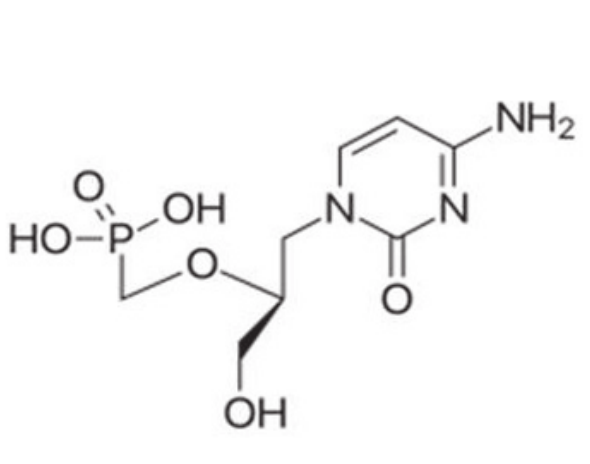
FIGURE 1 - Chemical structure of